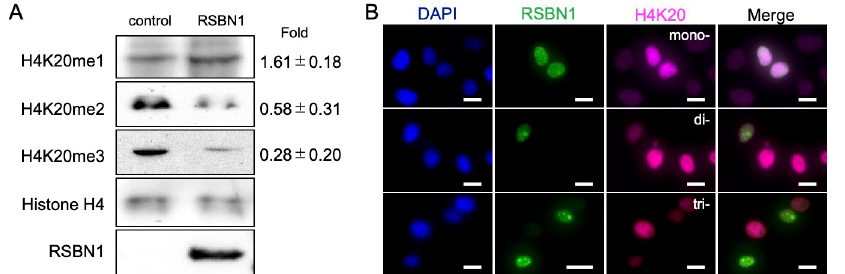
Fig 3. Demethylation activity of RSBN1. (A) Immunoblot results of methylated H4K20 in non-transfected cells (control) and transfected cells ( Rsbn1 ). Values of relative Fold Change of band density (RSBN1/Control) are shown at right of each images. (B) An effect of RSBN1 expression on methylated H4K20. Immunostaining images of nucleus (DAPI, blue), RSBN1 (green), tri-methylated (magenta: Top), di-methylated (magenta: Middle), and mono-methylated (magenta: Bottom) H4K20 examined in RSBN1 expressing HeLa cells are shown. Scale bars = 20 μ m.